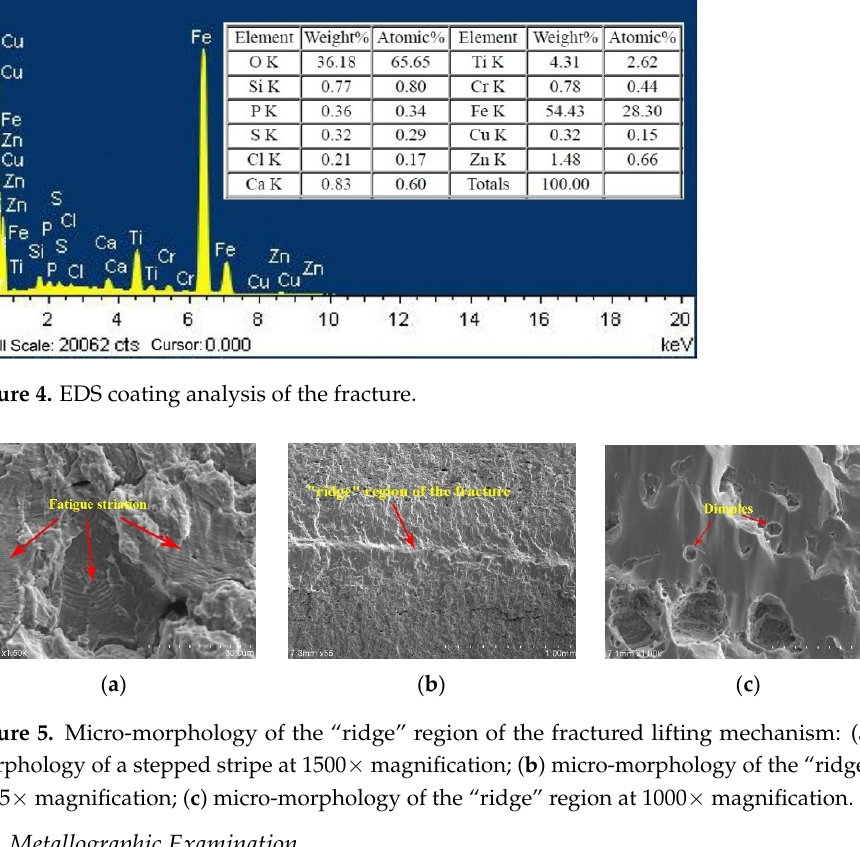
Figure 3. SEM morphologies of the fractured lifting mechanism: ( a ) micro-morphology of the fracture at 11× magnification; ( b ) micro-morphology of the fracture at 300× magnification. Figure 4 reveals the energy-dispersive X-ray spectroscopy (EDS) of the fracture. It can be seen that the contents of O, Ti, Fe, and Zn in the abnormal covering are higher, where the total atomic percentage of O and Fe is 90.61%, mainly composed of iron oxi- dation products. Therefore, it can be inferred that the loose coverings and pits on the fracture surface are caused by corrosion. This phenomenon not only demonstrates that the fracture of the wheelset lifting is a slow process, but also accelerates the eventual fa- tigue fracture. Figure 5 shows the micro-morphology of the “ridge” region in the middle of the fracture, where fatigue striation and dimple morphology can be observed in the local area, which is the final fracture region.